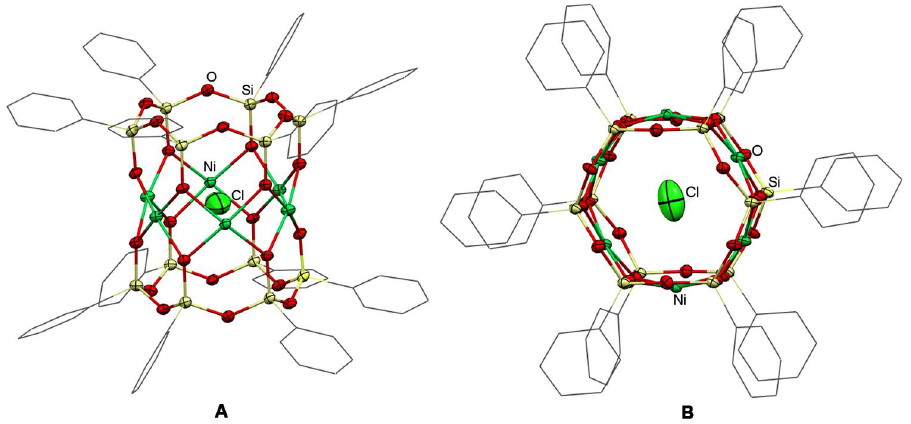
Figure 1. Molecular structure of compound 1 ( A —side view, B —top view). Solvating ligands and counter ion Na + are omitted for clarity.